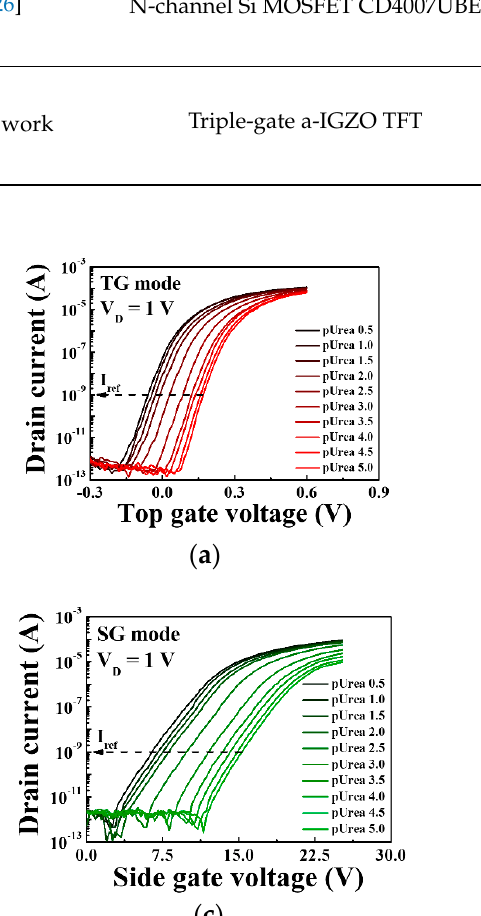
the triple-gate a-IGZO TFT-based urea-EnFET sensor platform as a function of pUrea.